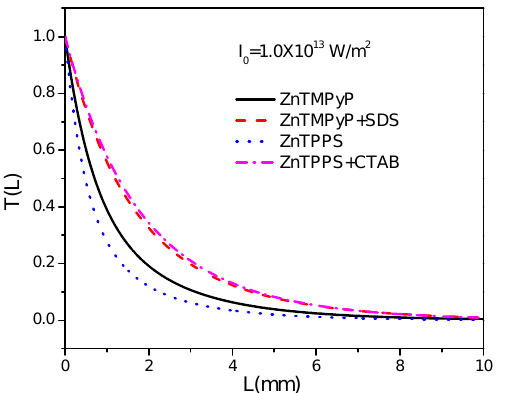
Figure 4. Energy transmittance T ( L ) (Equation (6)) as a function of the propagation distance L with I 0 = 1.0 × 10 13 W/m 2 for ZnTMPyP and ZnTPPS in aqueous solutions and their porphyrin J-aggregates with micelles of SDS and CTAB. N = 2.9 × 10 23 /m 3 . Taking ZnTPPS as an example, we studied the output intensities after OL absorption at L = 1.0 mm for different concentrations N = 2.9 × 10 23 /m 3 , N = 2.9 × 10 24 /m 3 in Figure 7. At r = 0 in Figure 7a, we could see that the output intensity decreases 2 ∼ 3 orders of magnitude with big concentration N = 2.9 × 10 24 /m 3 , and the peak intensity occurs earlier than the cause with small concentration. Comparing the two-dimensional pic- tures Figure 7b,c, we could notice that the shape of output intensity becomes asymmetric with big concentration. This is because the front part is mainly the two-step absorption ( S → S ) × ( T → T ) , while the latter part is dominated by the one-photon absorption 0 2 1 1 T 1 → T 2 depending on population ρ T . The different absorption mechanisms lead to the 1 asymmetric phenomenon. Big concentration means more molecules taking part in the nonlinear absorption and therefore the asymmetry becomes more